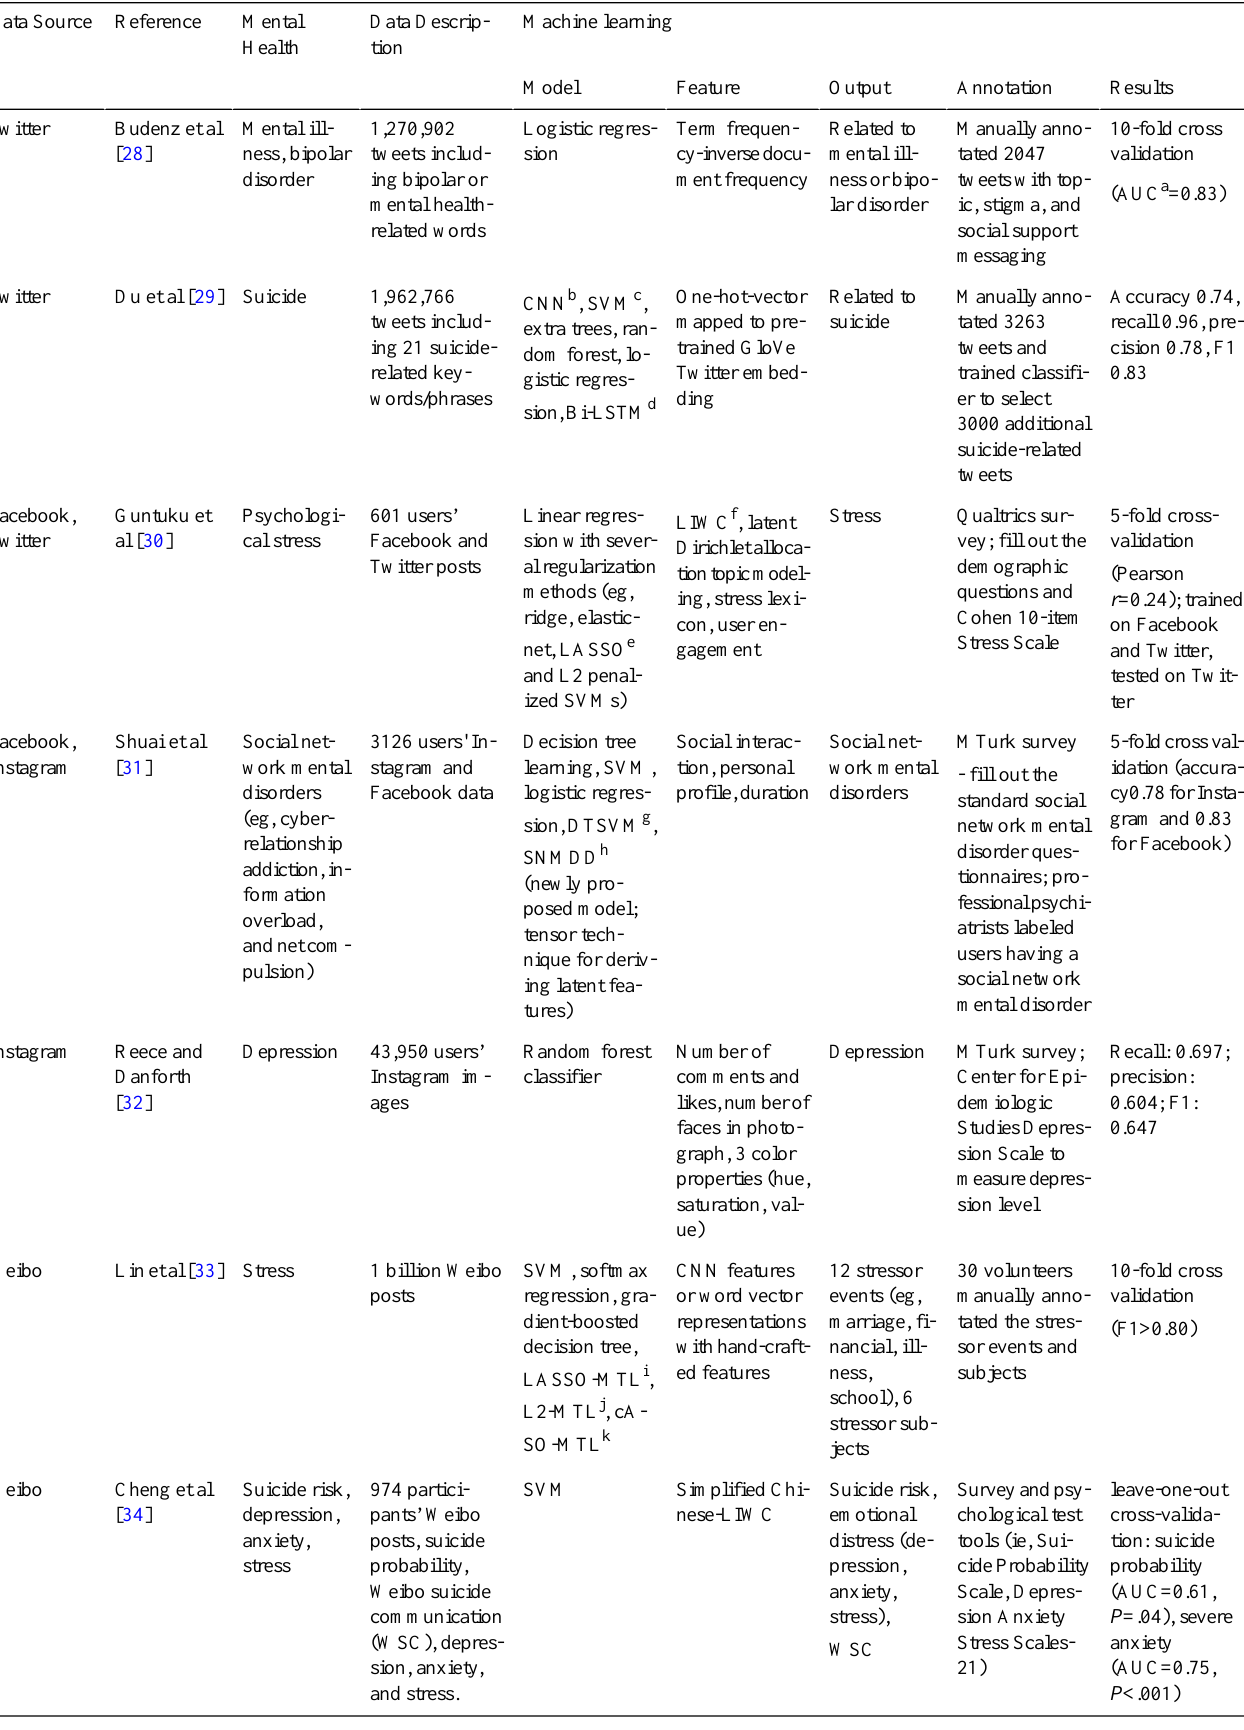
Table 9. Summary of research methodologies employed in highly cited